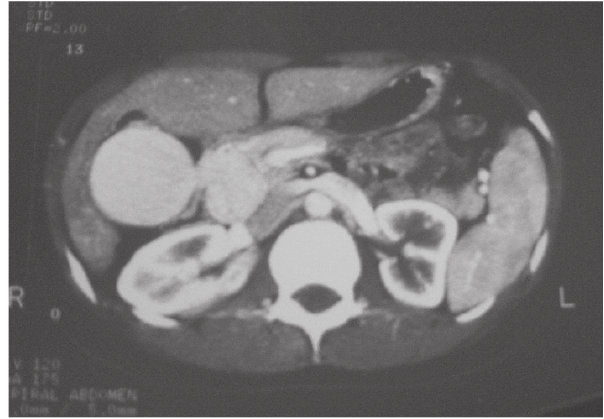
Figure 5 - Computed tomography showing the portal vein aneurysm with high signal similar to that of the aorta and the inferior vena cava and no significant change in size and shape. Performed in